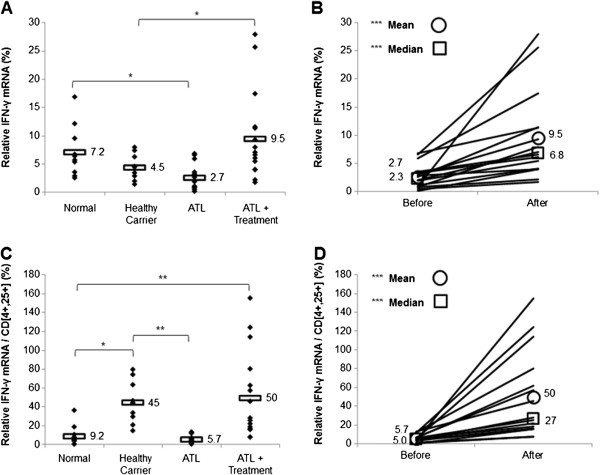
Treatment with arsenic/IFN/zidovudine increased IFN-γ expression. A. IFN-γ transcript levels in normal blood donors (n=10), healthy carriers of HTLV-I (n=10) and ATL patients (n=16) at initiation and 30 days after treatment with arsenic/IFN/zidovudine. Rectangles represent mean values. B. Mean and median IFN-γ transcript levels of individual ATL patients at initiation and 30 days after treatment with arsenic/IFN/zidovudine. C, D. Relative expression of IFN-γ transcripts after normalization to the number of CD4+CD25+ ATL cells. All values are expressed as percentage of human beta2-microglobulin used as internal control. *, **, *** indicate p values less than 0.05, 0.01 and 0.001 respectively.